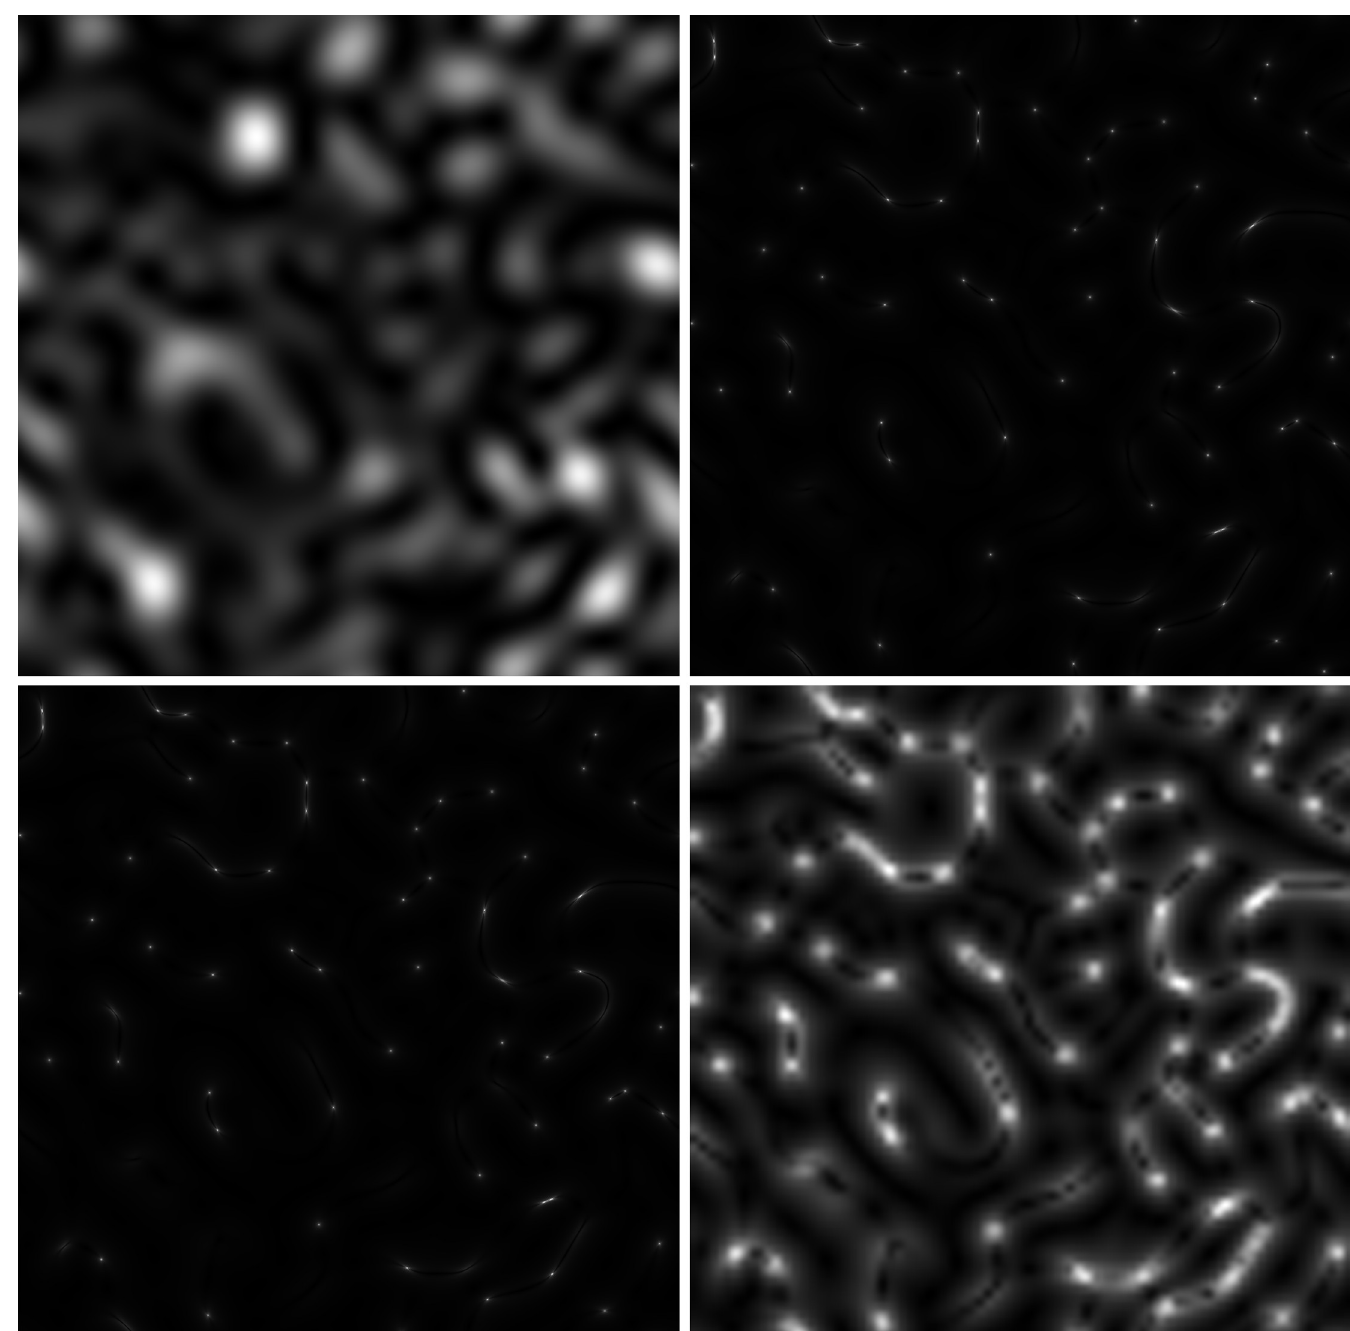
Fig 2. Dependence of the structure of s-LASCA images of GB-speckles, obtained for gatA gene on the AS parameter. (a) AS = 1. (b). AS = 2 (c). AS = 5 (d). AS = 50.